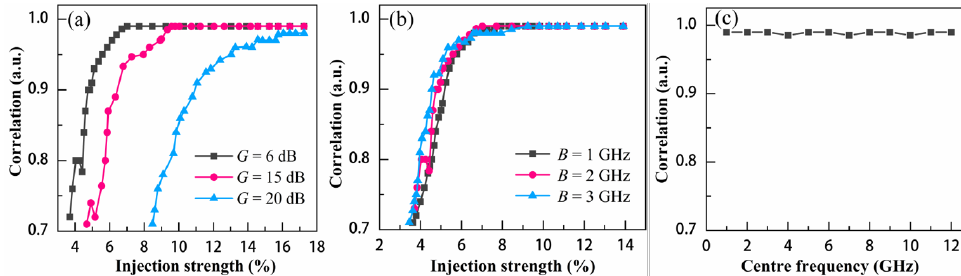
Figure 4. Correlation coefficient versus injection strength for different ( a ) amplifier gains and ( b ) filter widths; ( c ) correlation coefficient versus centre frequency of filter.